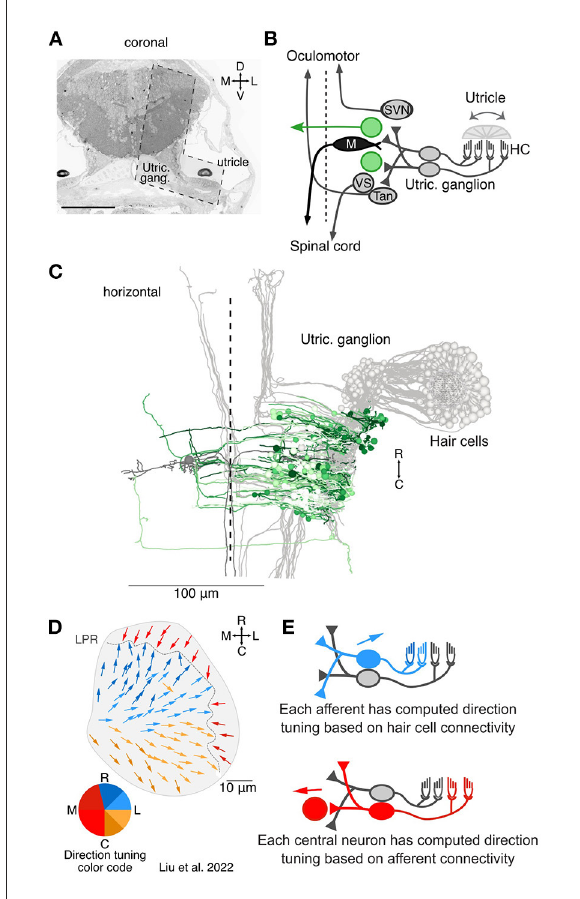
FIGURE1 Overview of the central targets of utricular afferents. (A) Coronal section of 5.5 dpf larval zebrafish showing the total area imaged originally by Hildebrand et al. (18) and the area re-imaged at 4 × 4 × 60 nm 3 per voxel (L shaped, dashed outline). This area was re-imaged across 105 µ m in the rostrocaudal axis (1,757 coronal sections). Scale bar, 100 µ m. Reprinted from (19). (B) Circuit schematic highlighting the central vestibular targets described here (green) in the context of the utricular / motor circuit (gray). We identified both commissurally-projecting central neurons and neurons whose axon could not be traced extensively. (C) Horizontal projection of the utricular circuit. As in (B) , greens represent neurons described here and grays represent neurons described in Liu et al. (19). Dashed line represents midline. Utricular afferent somata are in the utricular ganglion. (D) Directional tuning of all 91 hair cells in the utricular macula, horizontal view. Each vector represents the best direction of tilt responsiveness, as inferred from the positions of the kinocilium and stereocilia. To facilitate visualization, the directional tuning is also encoded with a color scheme, lower left. Tuning for ipsilateral and rostral tilt is shown in blue, for ipsilateral and caudal tilt in yellow, and contralateral tilt in red. The directional representation is slightly asymmetric to accommodate the patterns of the hair cells. LPR, line of polarity reversal. Data from Liu et al. (19). (E) Schematic of computed tuning for afferents and central neurons. Afferent tuning was computed as a weighted circular average based on the number of ribbon synaptic inputs from hair cells. Central neuron tuning was in turn computed as a weighted circular average based on the number of afferent synaptic contacts. We note that these directional tuning responses only take into account monosynaptic, utricular inputs, not canal inputs or polysynaptic